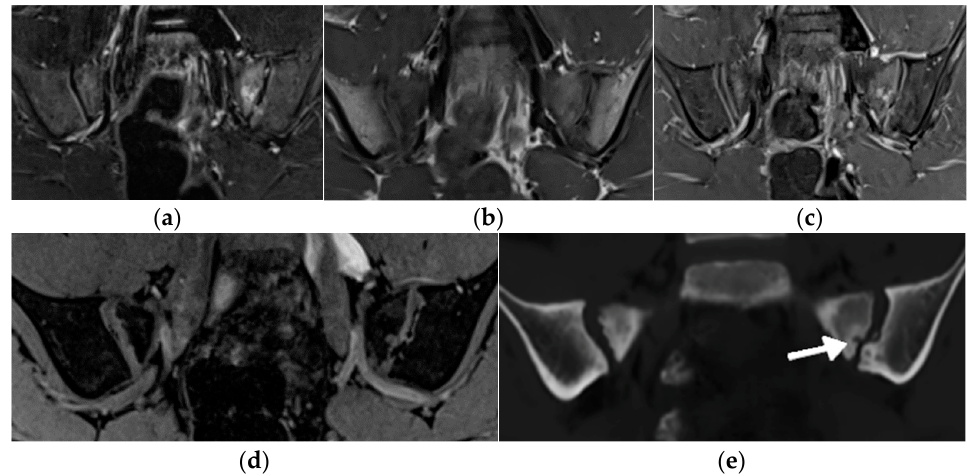
Figure 9. MRI of the sacroiliac joints of a 11-year-old boy with an active erosion in the left sacrum seen in consecutive sequences: T1-weighted time spin echo (TSE) ( a ), T2 short tau inversion recovery (STIR) ( b ), postgadolinium fat-saturated T1-weighted MR image ( c ), T1 volume-interpolated breath-hold examination (VIBE) ( d ), and BoneMRI ( e, arrow).